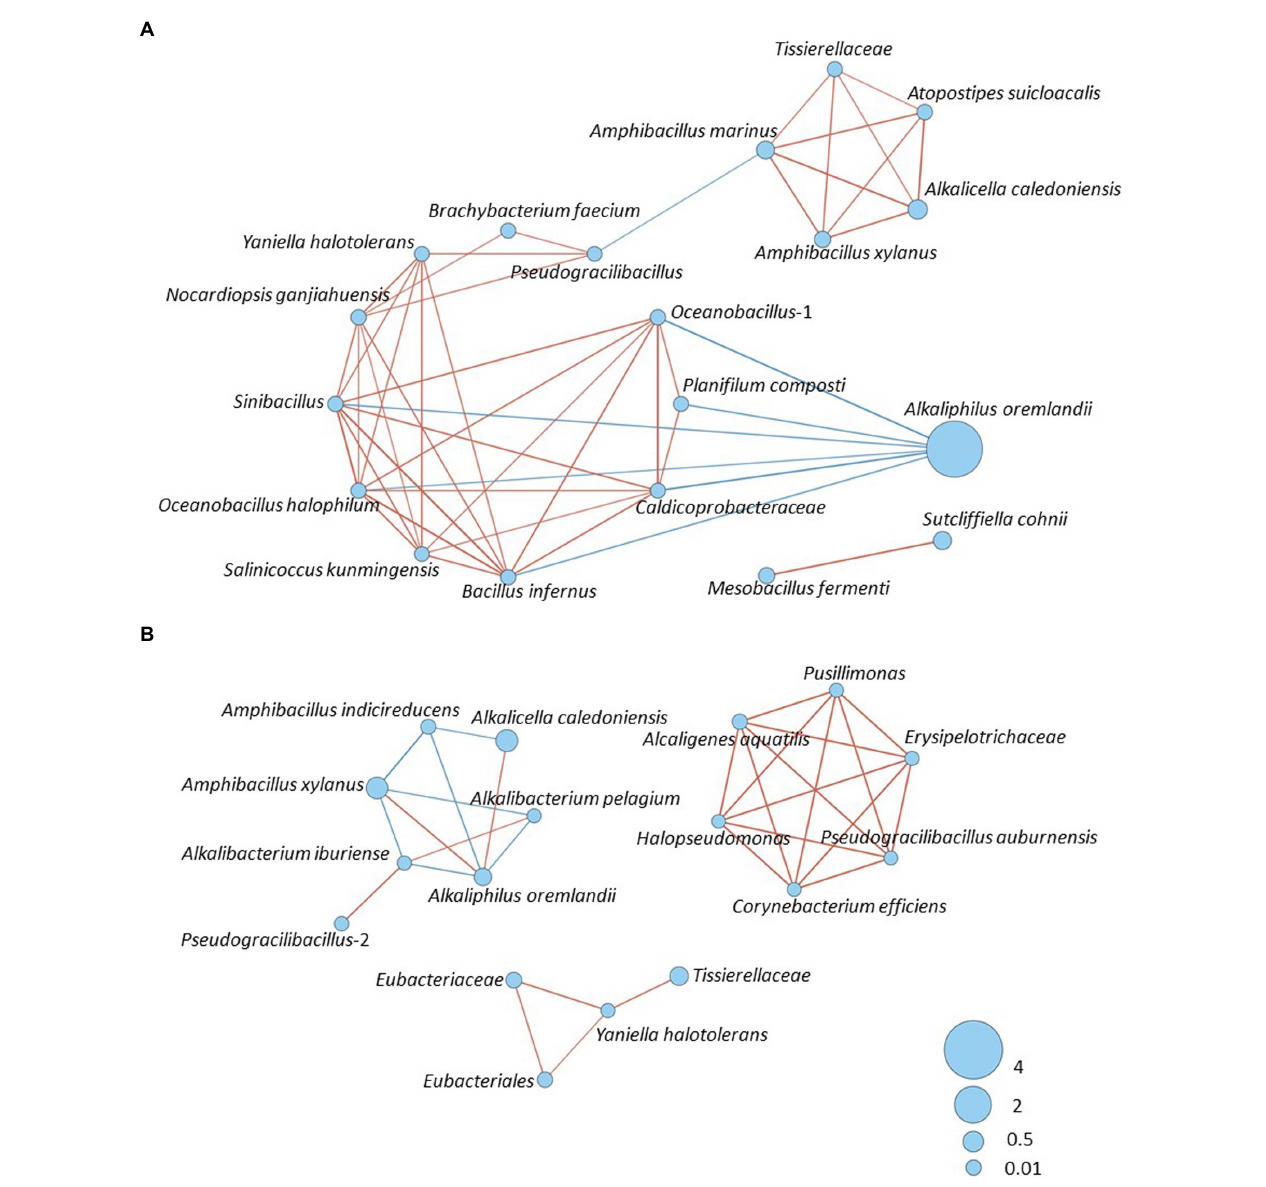
FIGURE 5 Bacterial community networks of the bacterial community based on the relative content change trend analyzed with Speaman’s rank correlation coefficient [ rs > 0.6, p < 0.05]; (A) Batch 4, days 1–7. (B) Batch 4, days 10–209. The red and blue lines represent positive and negative correlation, respectively. The thickness of the lines corresponds to the strength of the relationship (0.6 < rs ≤ 1), while circle size shows accumulated taxon abundances during each fermentation